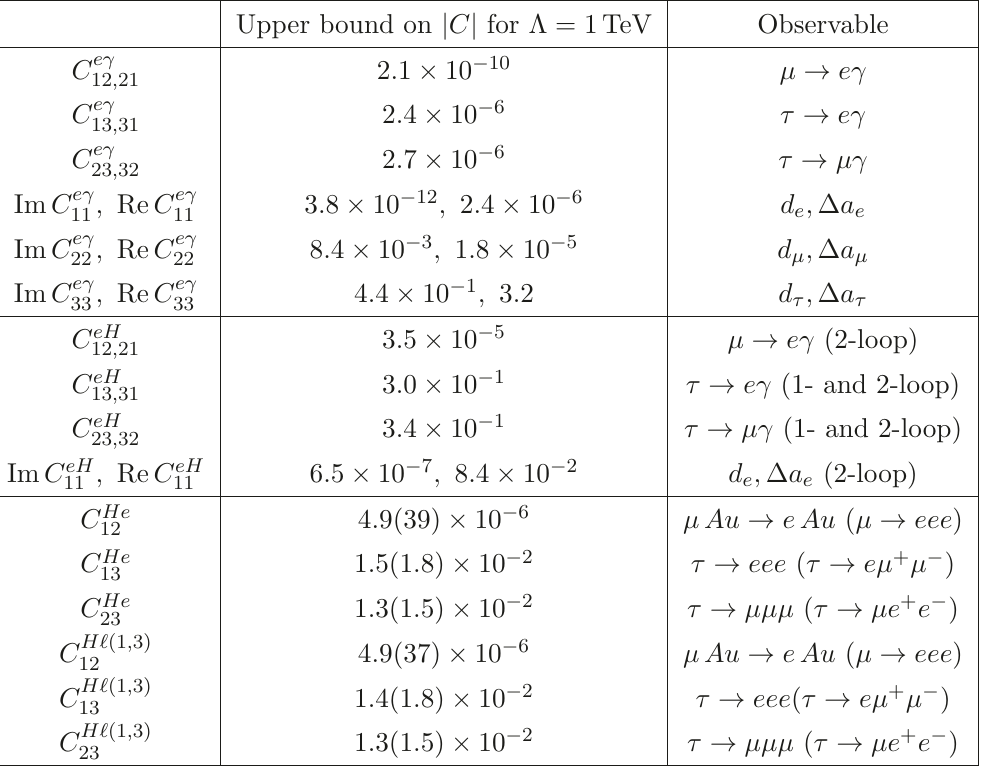
Table 4 . Most relevant constraints on the Wilson coefficients of two-lepton operators. These values (when there is overlap) agree pretty well with [32], except for the 1/2-loop effects (see section D.2), because we use the latest experimental constraints on radiative